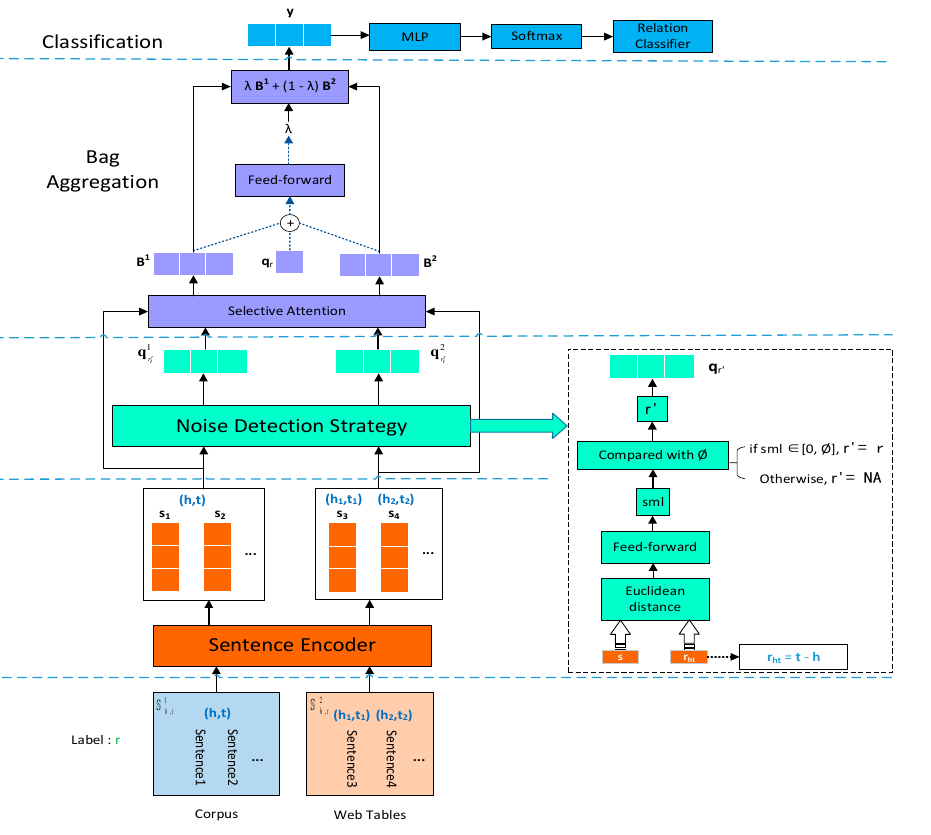
Figure 1. The architecture of our proposed method (the noise detection-based relation extraction model, NDRE) used for distant supervised relation extraction. MLP: multi-layer perceptron.